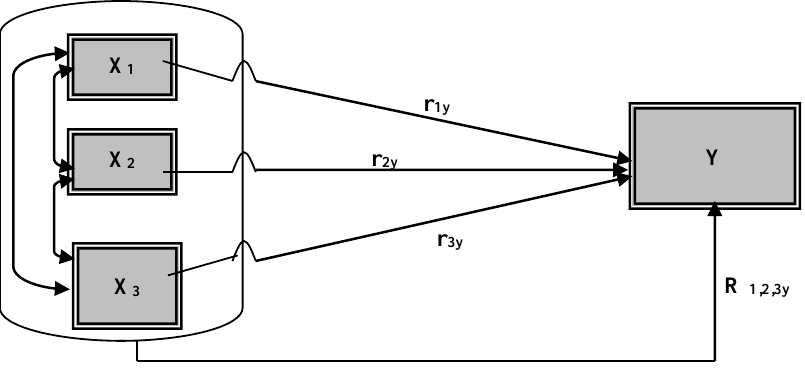
Figure 1. Constellation of Research